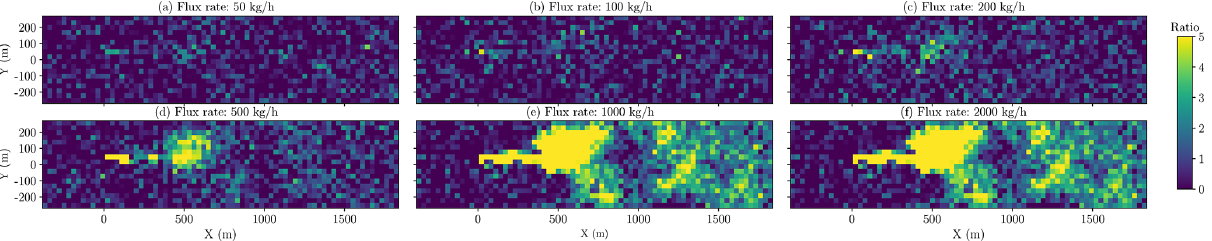
Figure 19. Ratio of retrieved CH 4 excess column, divided by the posterior precision error, over a simulated scene in the Durango, Colorado, area for plumes of various emission rates. The spatial resolution is 30m, the instrument FWHM is 1.5nm, and the polynomial degree in the retrieval is 25. The realistic surface distribution is based on LANDSAT data. Ratios higher than 4 imply a probability, of lower than 1 in 15000, that the pixel enhancement happens by random